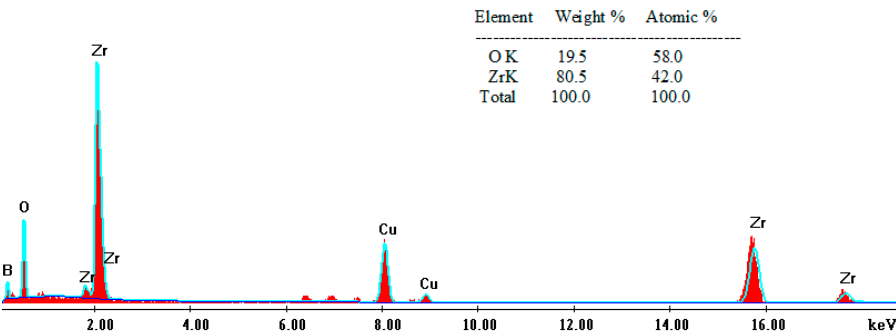
Figure 3. EDX spectrum of ZrO 2 NTs annealed at 550 °C.